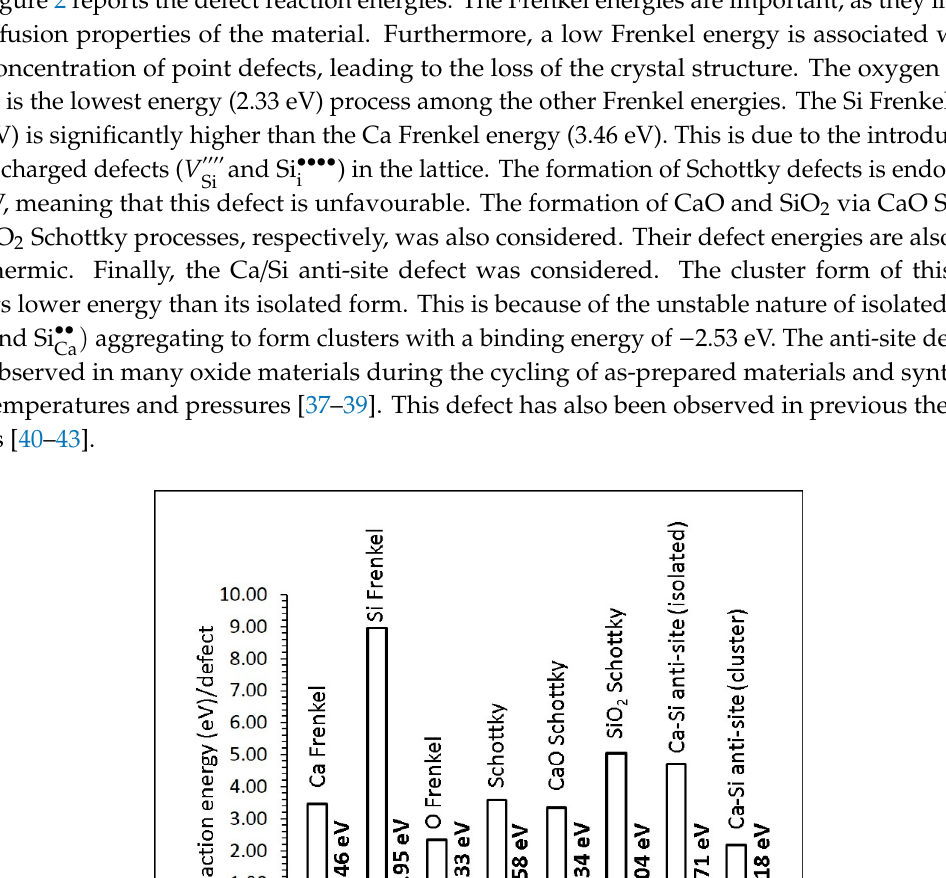
Table 3. Activation energies calculated for local Ca hops.